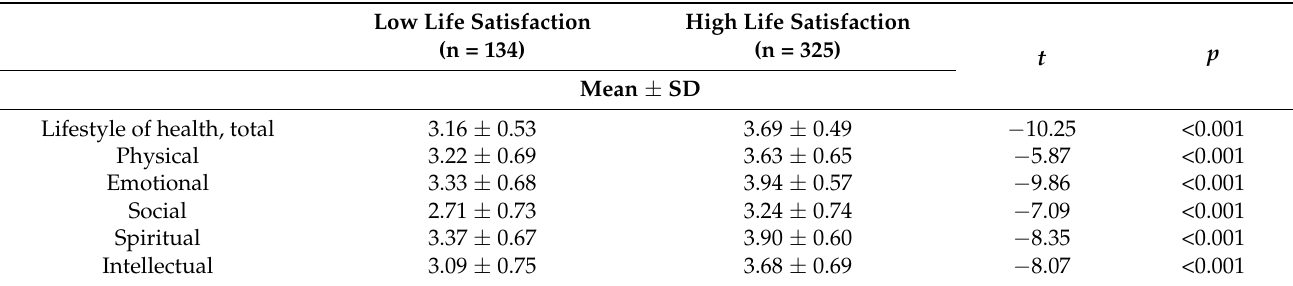
Table 3. Comparison of differences in lifestyle behavior according to life satisfaction.